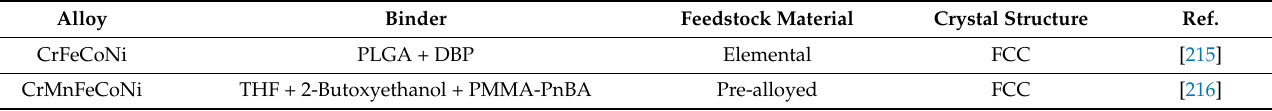
Table 9. Composite materials with HEA matrix .